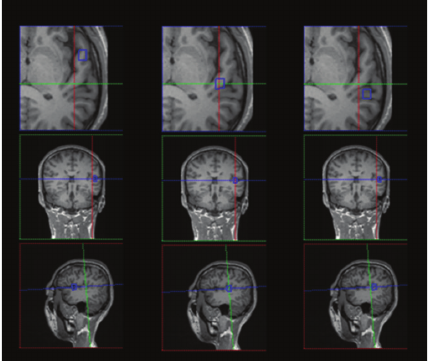
Figure 2: Representative images showing voxel selection from different regions of the left auditory cortex in the multivoxel spectra matrix for spectral reconstruction. The figure shows voxels selected from different regions of the anterolateral aspect of first Heschl’s gyrus (left), the posteromedial aspect of first Heschl’s gyrus (mid- dle), and the planum temporal (right). Note: the middle blue frame indicates the region of interest. From top to bottom, the figure shows the axial, coronal, and sagittal positioning